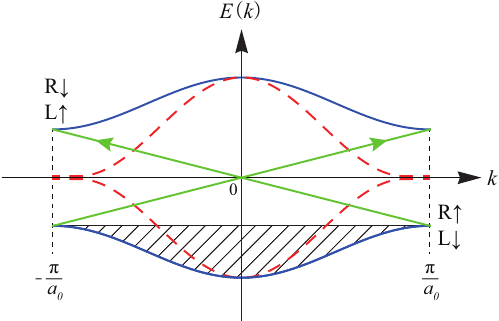
Figure 9. Schematic display of band structure for interacting ZGNR in absence of disorder (solid lines). (The gap size is exaggerated). Only bands near the gap are displayed. The natures of the π unoccupied and occupied states near k = are given ( a 0 is the unit cell length of the ZGNR): R and a 0 ± L represent states localized on the right and left zigzag edges, respectively. Small arrows indicate spins. The bandstructure for non-interacting electrons is represented by dashed lines. There are numerous zero-energy states near the Brillouin zone boundary, which split in the presence of on-site electron repulsion U (this splitting is analogous to the energy splitting shown in Figure 8. The long arrow indicates coupling between states R and L or R and L ↑ ↑ ↓ ↓